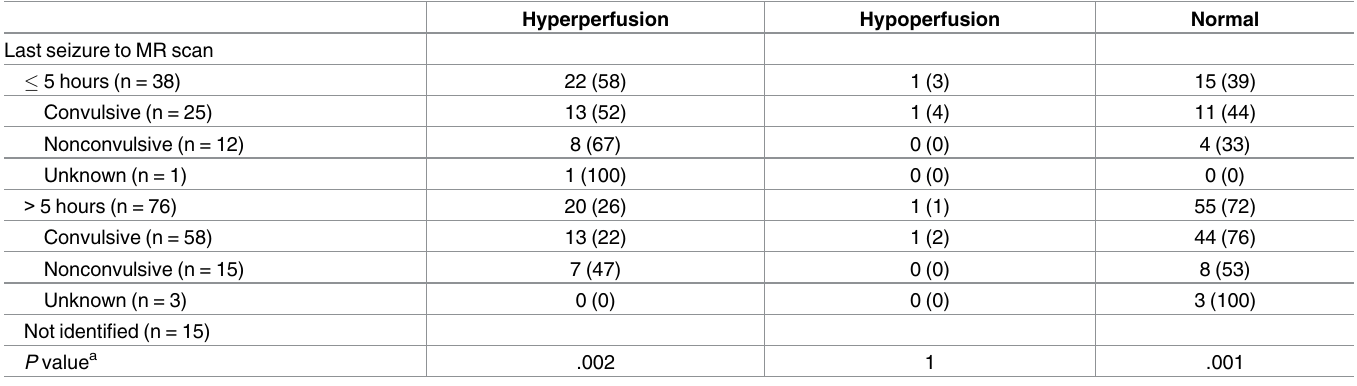
Table 2. Perfusion patterns in seizure patients (convulsive vs. nonconvulsive) with known time intervals between the last seizure events and MR scans.